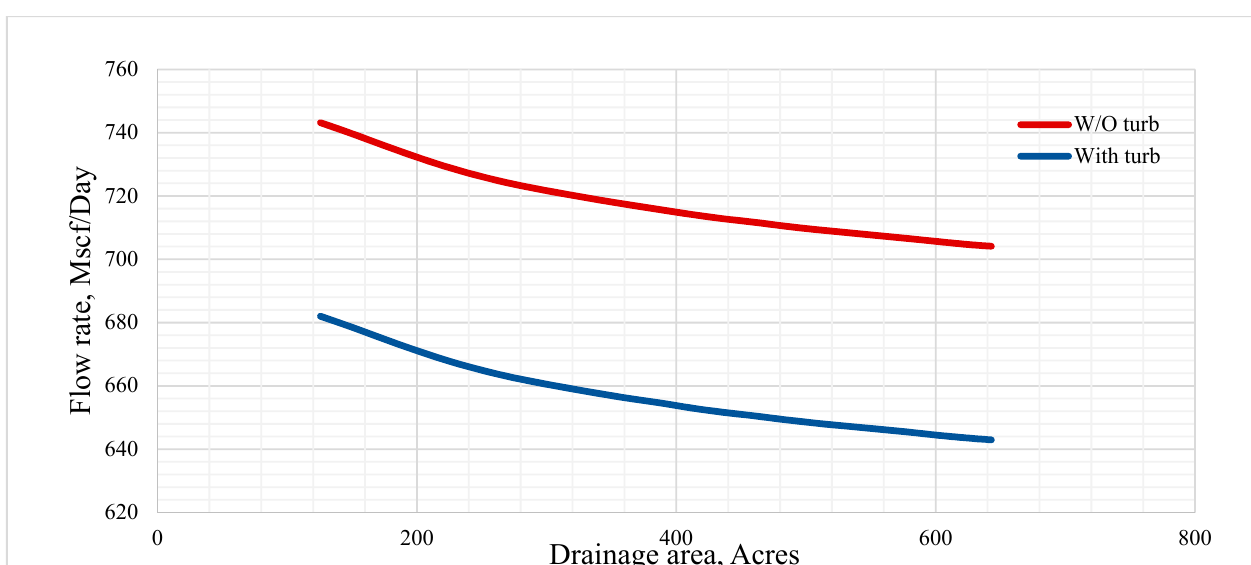
Figure 12. Gas flow rate versus drainage area.